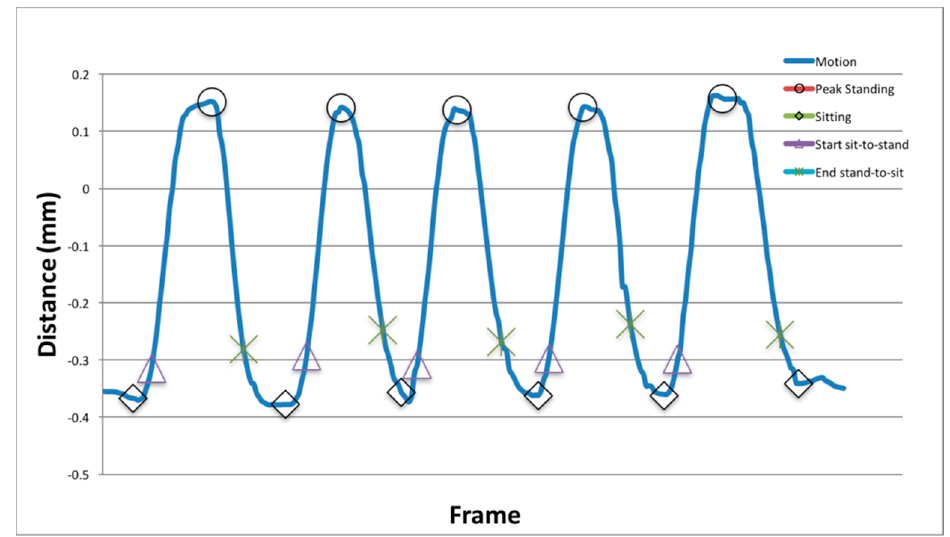
Figure 4. Example output of the proposed transition detection framework derived from the Centre-of-Mass feature vector.